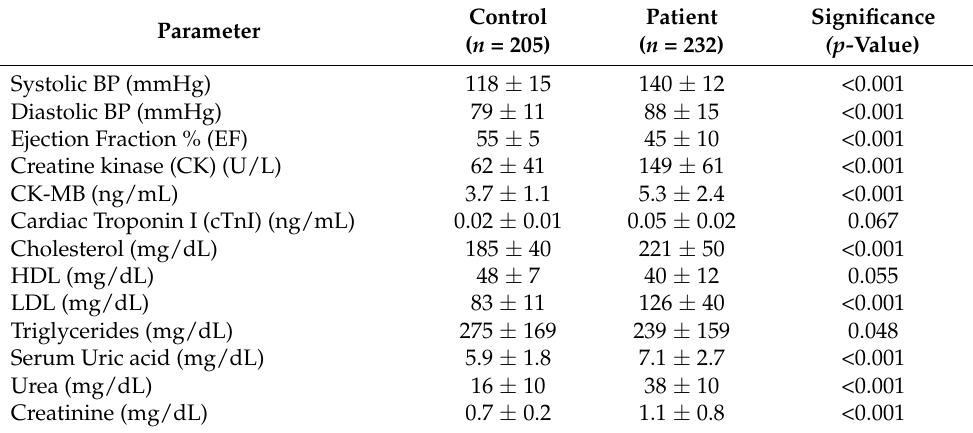
Table 2. Comparison of clinical and biochemical parameters in patients and healthy subjects.